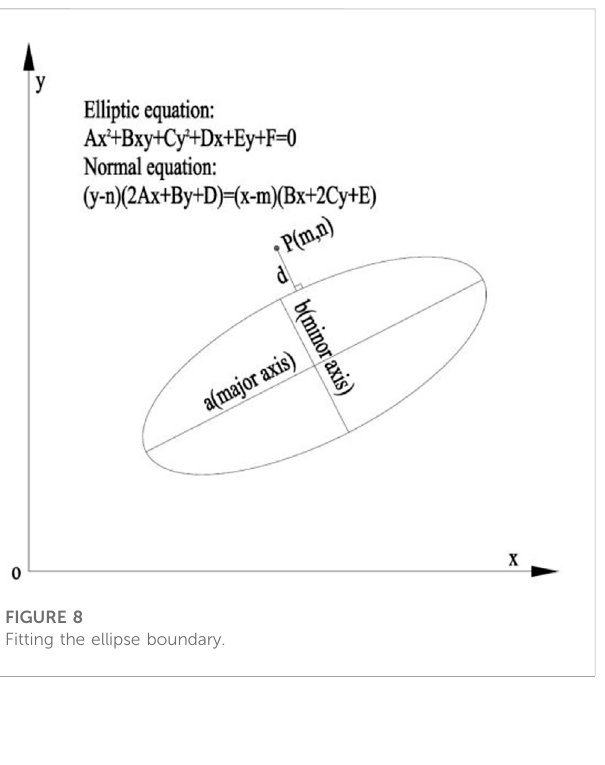
FIGURE 8 Fitting the ellipse boundary.